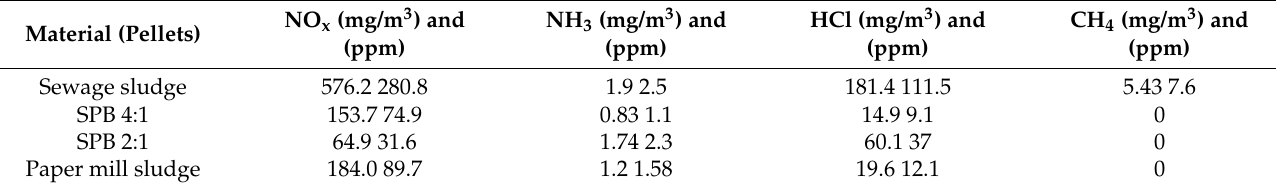
Table 5. Average concentrations in the flue